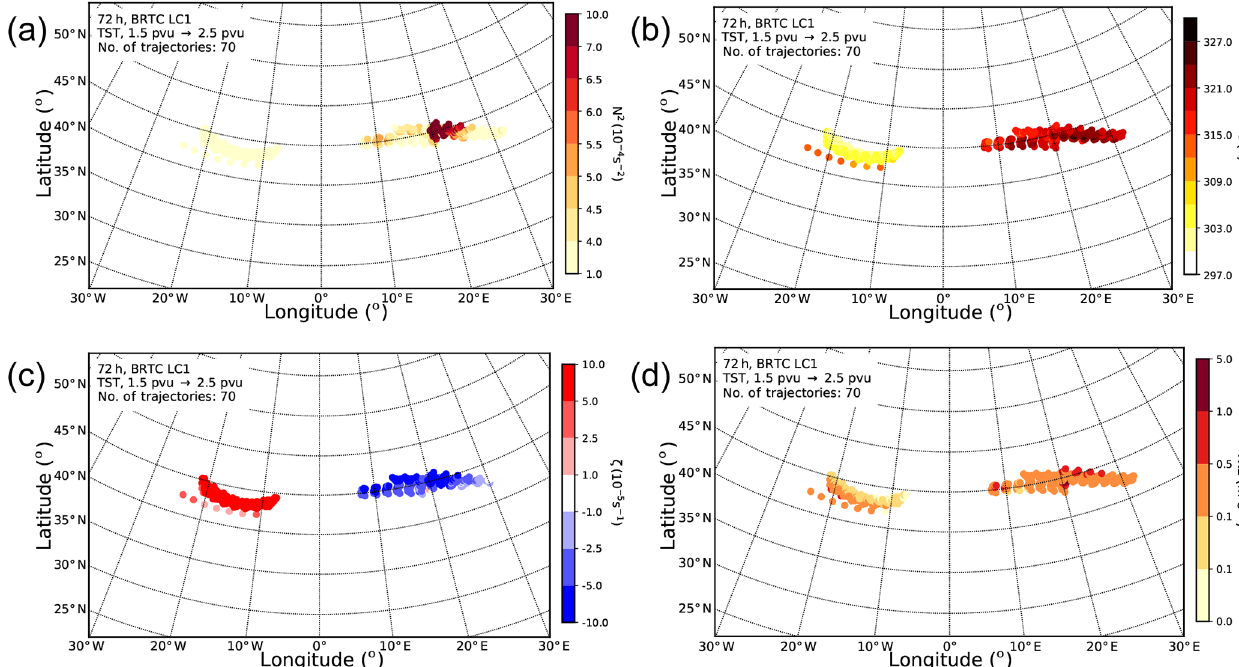
Figure 12. Trajectories starting 66h and ending 72h after model start which increase their PV from values smaller than 1.5pvu to values larger than 2.5pvu within the 6h interval. Panels show (a) static stability (in 10 − 4 s − 2 ), (b) potential temperature (in K), (c) relative vorticity (in 10 − 5 s − 1 ), and turbulent kinetic energy (in m 2 s − 2 ) along the trajectories for each hour.